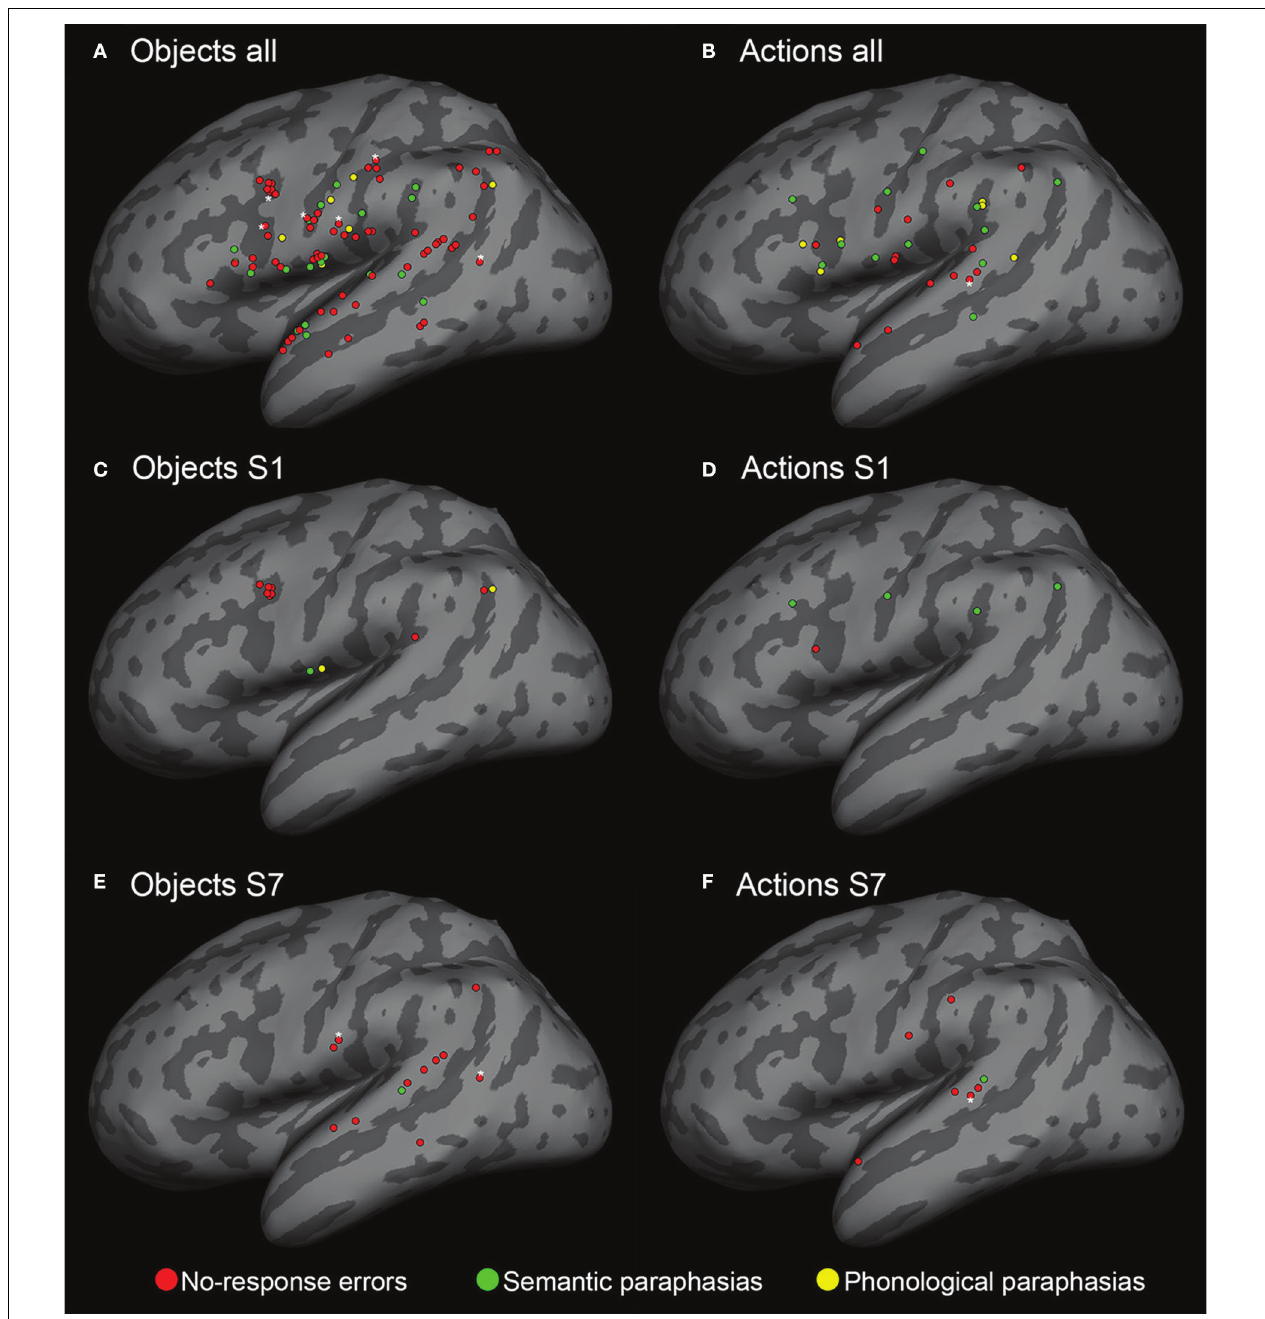
FIGURE 2 | Cortical sites for both object and action naming errors visualized on an inflated reconstruction of the cortex. Red spheres: no-response errors; green spheres: semantic paraphasias; yellow spheres: phonological paraphasias. ( A , B) All cortical sites that elicited nTMS-induced